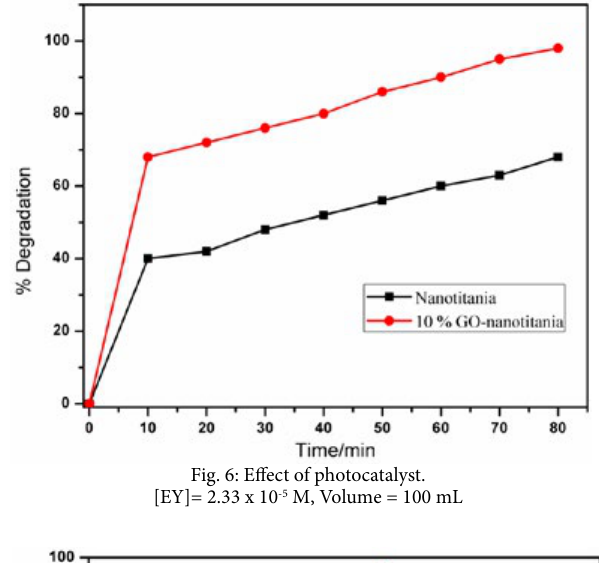
Fig. 6: Effect of photocatalyst. [EY]= 2.33 x 10 -5 M, Volume = 100 mL Fig. 6 Effect of photocatalyst.